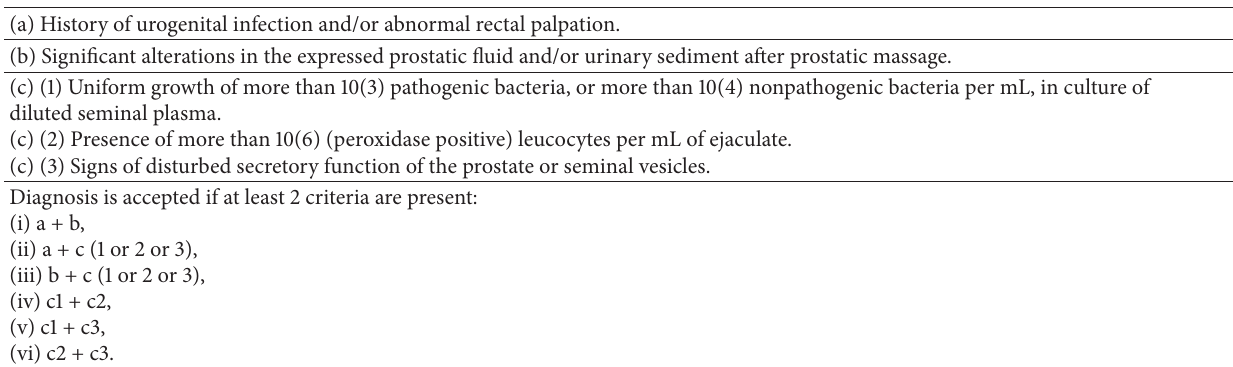
Table 1: Clinical criteria for diagnosis of MAGI.